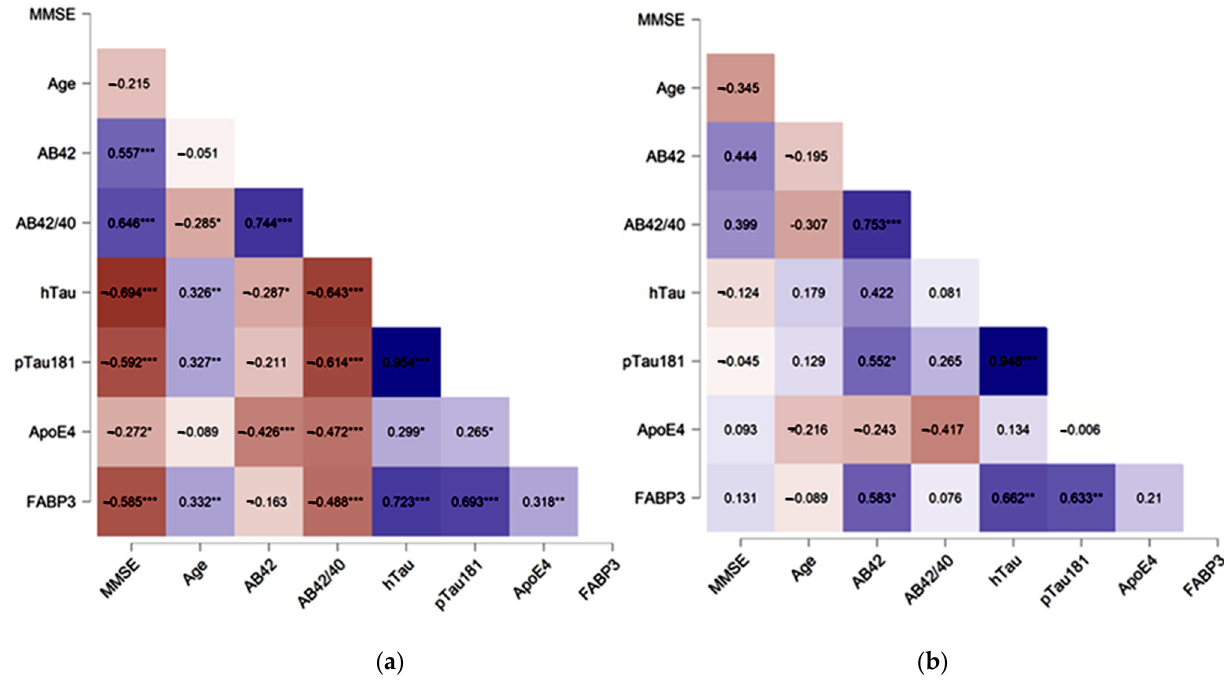
Figure 2. Spearman’s correlations between CSF tested proteins and neurochemical dementia biomarkers in the whole study group ( a ) and MCI subjects ( b ). NOTE Levels of statistical significant * p < 0.05, ** p < 0.01, *** p <0.001. MMSE—mini mental state examination score.